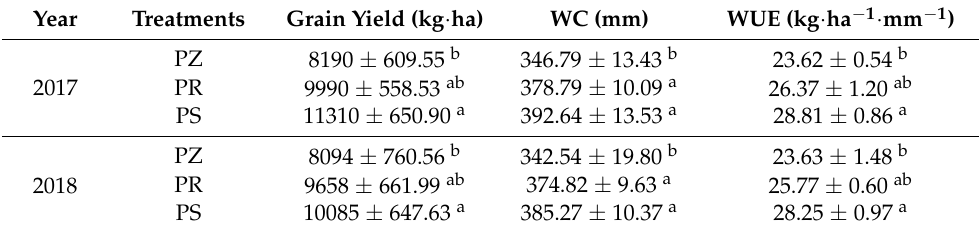
Table 7. Grain yield and water use efficiency of winter wheat under different tillage